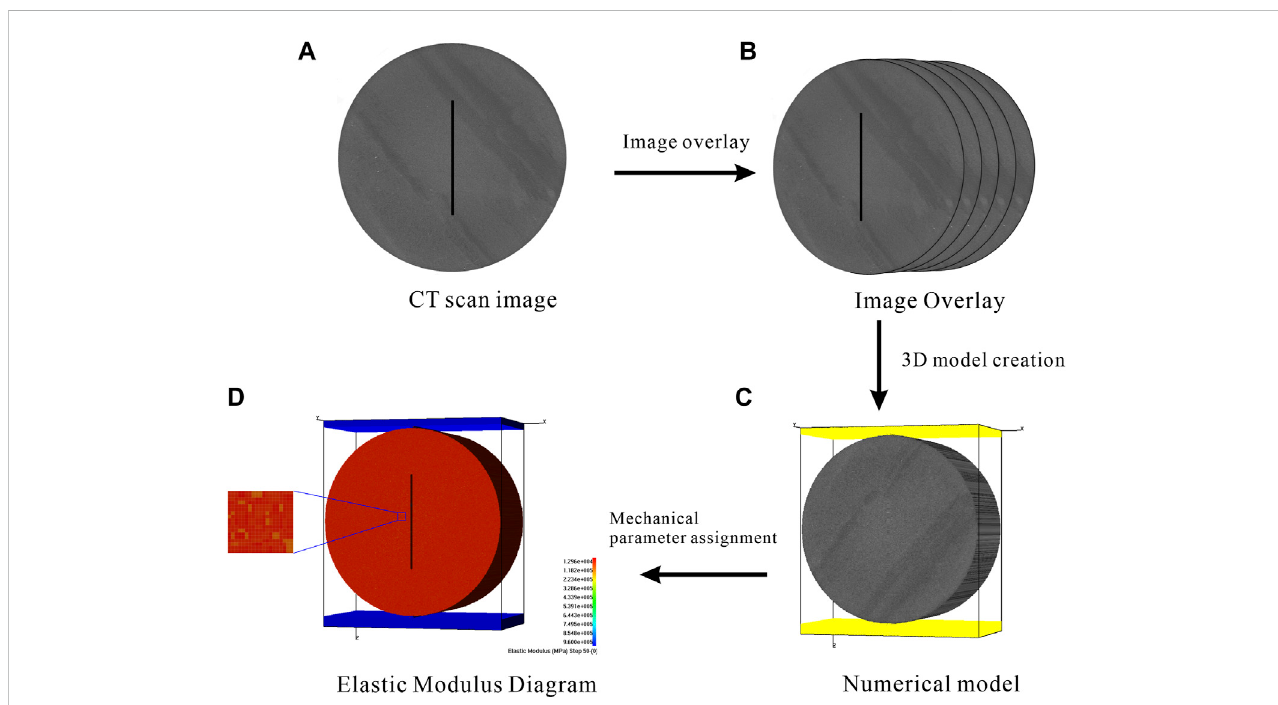
FIGURE 5 Flowchart of3Dnumericalmodelreconstruction. (A) CTscanimage. (B) Imageoverlay process. (C) Numericalmodel. (D) Diagramofelastic modulus of numerical model.